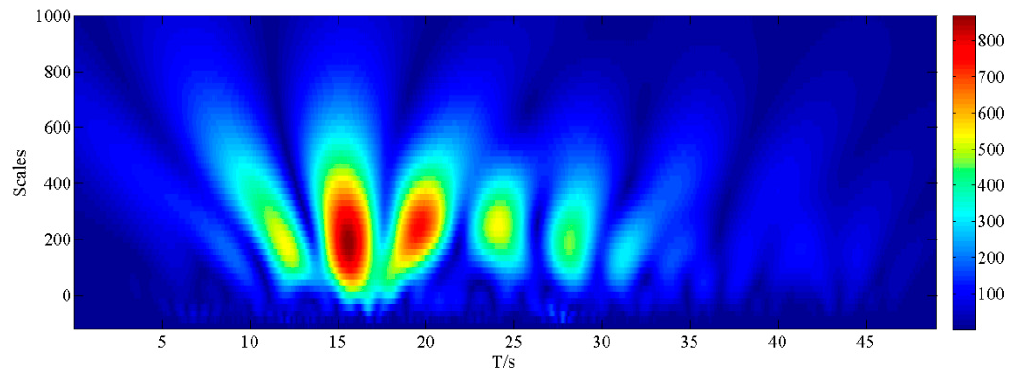
Figure 7. The resultant time–frequency plane C RST for the signal set at station TCU101.